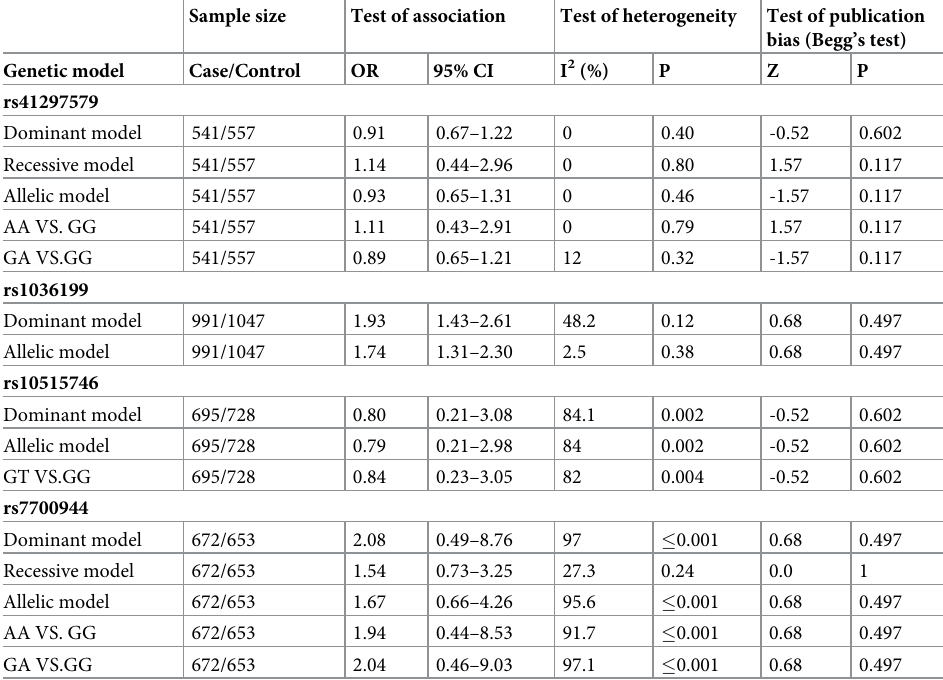
Table 3. Main results of pooled ORs in meta-analysis of Tim family